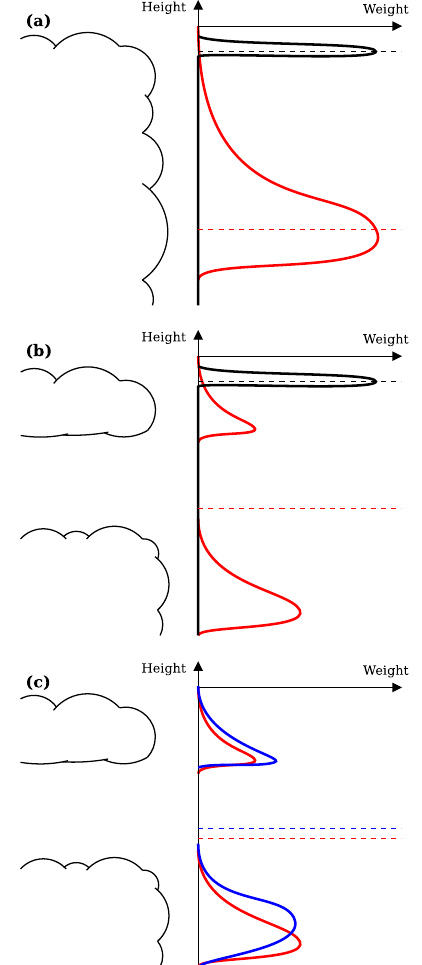
Figure 6. Schematic of the weighting functions for CTH for an in- frared radiometer (red) and lidar (black), with dashed lines denot- ing the value retrieved. (a) For a thick cloud, the radiometer is most sensitive to the region one optical depth into the cloud while the lidar detects the physical cloud top. (b) The lidar’s sensitivity is un- changed when a thin cloud lies over a thicker one, but the radiometer observes both clouds, resulting in an unphysical CTH somewhere between the two. (c) Compares (b) with the weighting function for a wider radiometer band (blue,